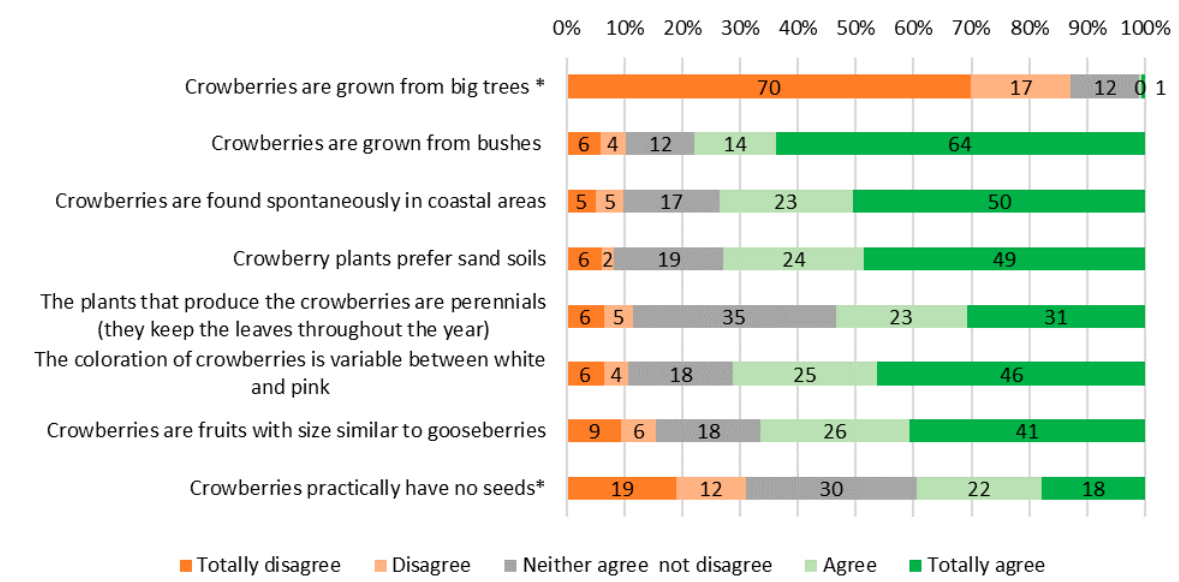
Figure 2. Level of agreement with statements related with general knowledge about crowberries (* denotes a false state- ment).